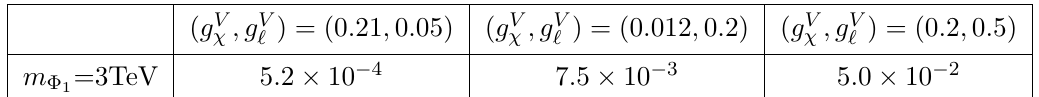
Table 2 . The cross section of dilepton production pp ! (cid:8) 1 ! ‘ + ‘ (cid:0) at 13 TeV LHC, where the cross sections are in unit of fb. The benchmark points satisfy the DM relic density, the DAMPE e + + e (cid:0) (cid:13)ux excess and the PandaX limits.